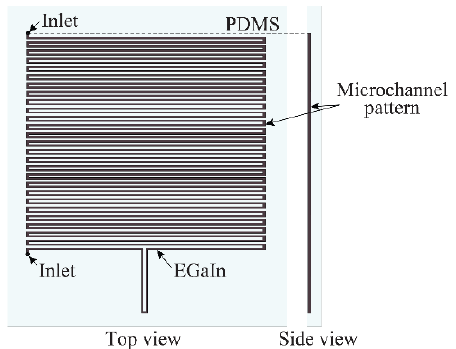
Figure 9. Top view and side view of the microstrip antenna fabricated by injection alloys in the microfluidic channels.